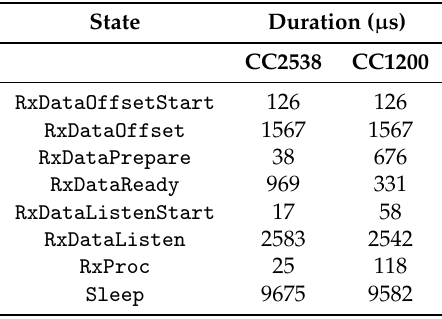
Table 10. State durations in the RxIdle time slot with a total length of 15ms.